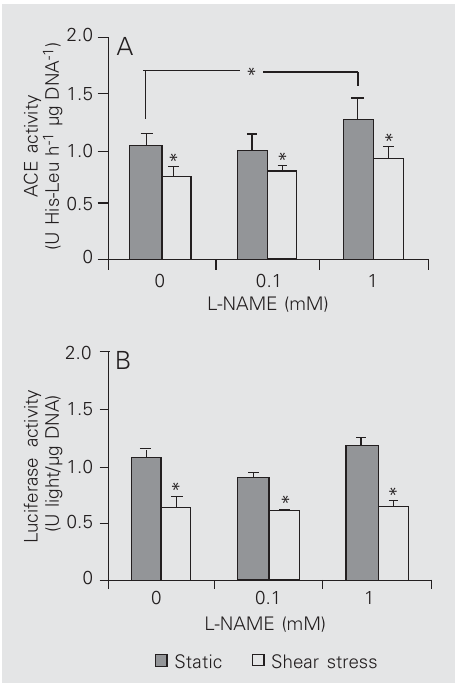
Figure 1. Angiotensin-I convert- ing enzyme (ACE) (A) and lu- ciferase (B) activity in WLuc cells under static conditions and sub- jected to shear stress of 15 dyn/ cm 2 for 18 h. The cells were treated with N G -nitro-L-arginine methyl ester (L-NAME) 1 h be- fore the beginning of shear stress and for the remaining pe- riod of the experiment. Each bar indicates the mean ± SEM of 8 experiments. The results were normalized to static cells with no treatment. *P < 0.05 com- pared to static control